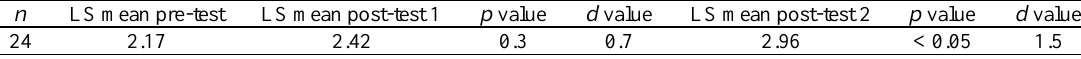
Table 4 ANOVA for problem recognition of the control